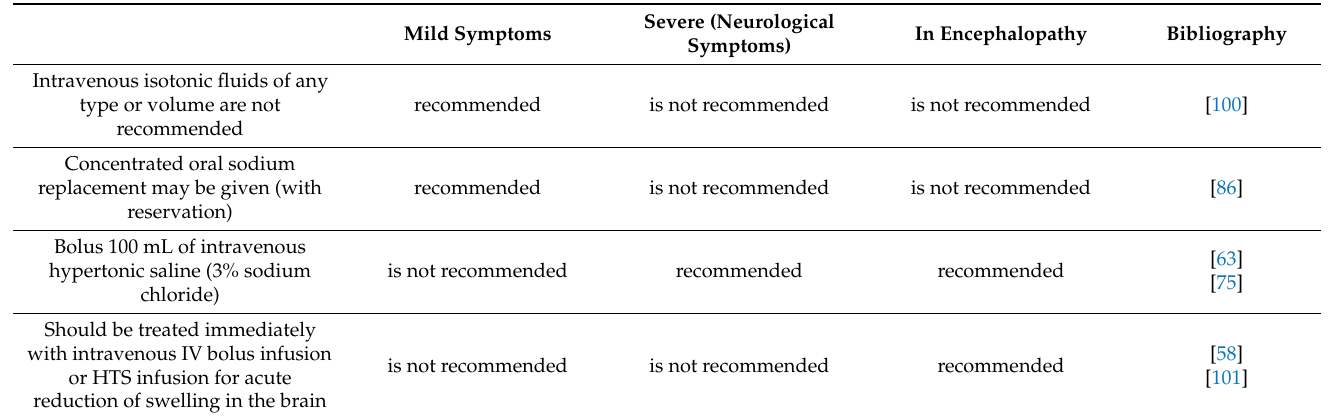
Table 5. Management of EAH